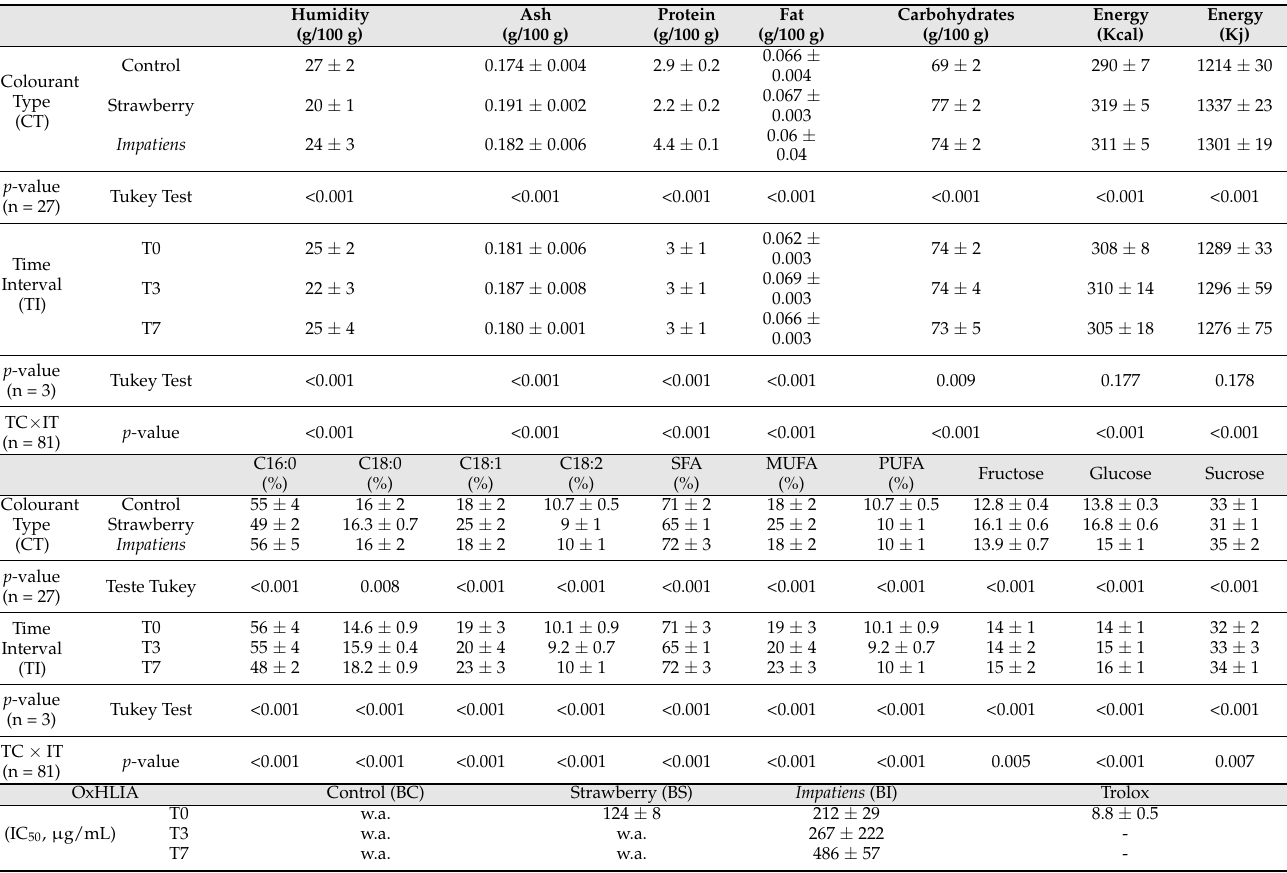
Table 4. Nutritional, chemical, and antioxidant activity profile of the formulations Control (BC), Strawberry (BS) and Impatiens (BI) in relation to shelf life (0, 3, and 7